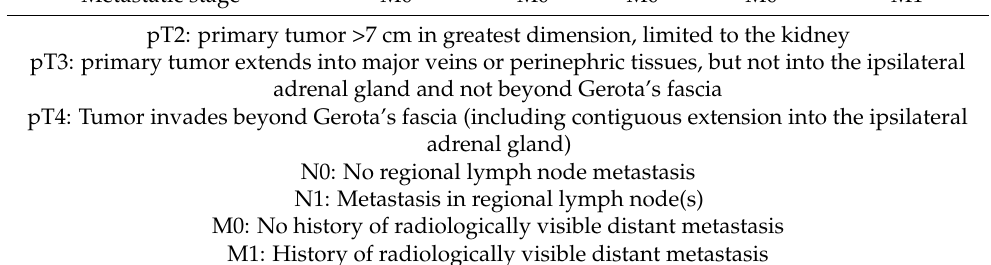
M1 with No Intermediate-High High Risk Evidence of Risk Disease pT2 pT3 pT4 Any pT Any pT Grade 4 or Any Any Any Any sarcomatoid grade grade grade